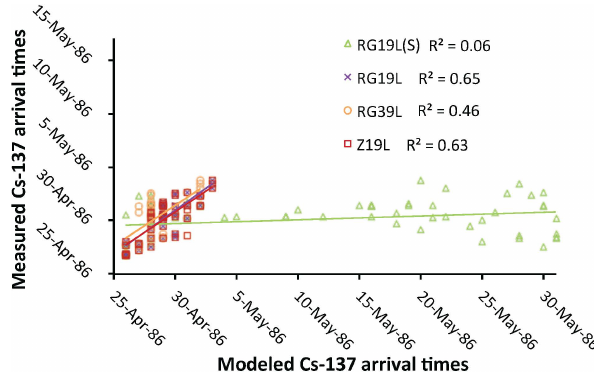
Fig. 9. Estimation of the arrival times of the radioactive fallout of 137 Cs after simulation using all model versions (RG19L(S), RG19L, RG39L and Z19L) and comparison with the respective ones obtained from the REM database. The data correspond to time- series measurements from 56 sampling points across Europe.